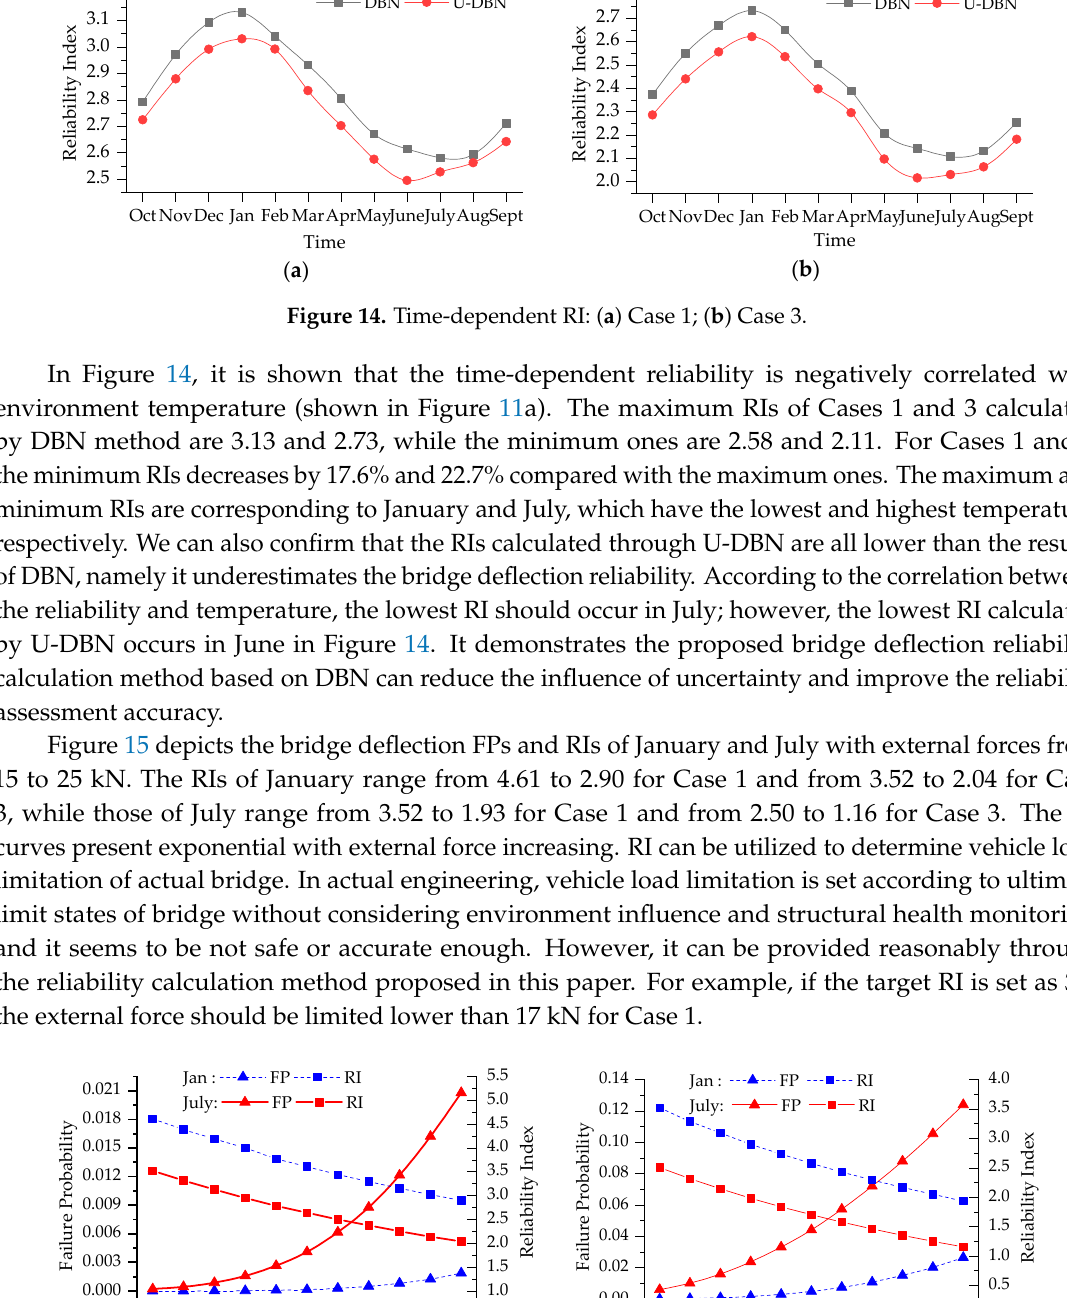
Figure 13. Boxplot of RI with different sampling numbers.